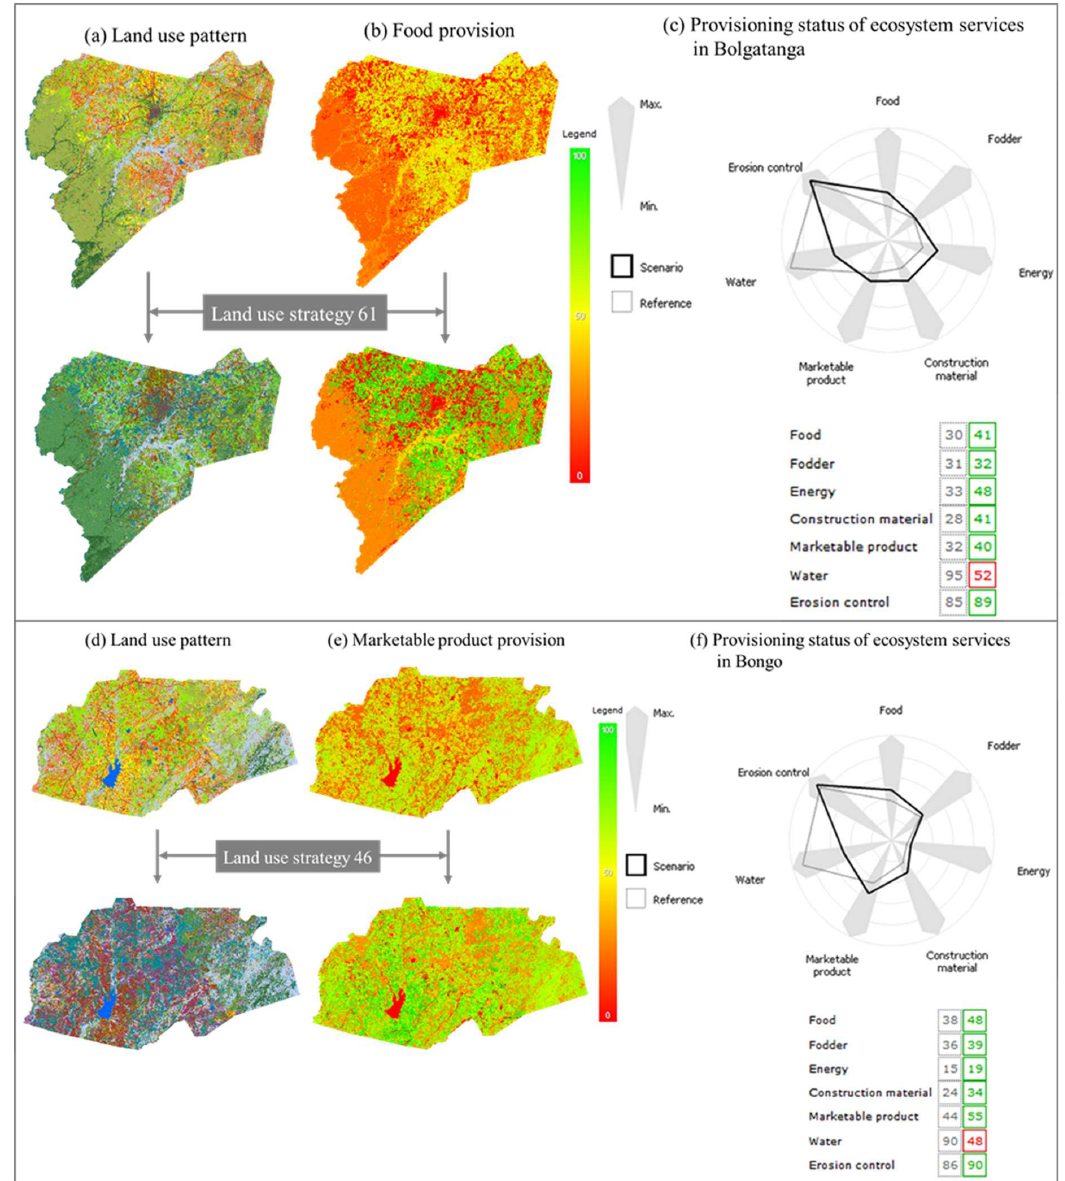
Figure 6. Future land-use pattern and changes in the provision of ecosystem services according to locally recommendable land-use strategies in Bolgatanga (top) and Bongo (bottom). The application of land-use strategies generates future land-use pattern ( a , d ). The spatial distribution of ecosystem services (e.g., food and marketable products provision) is influenced by the newly generated land-use pattern ( b , e ). The spider chart and the table present the changes in the provision of overall ecosystem services at district level compared to the current status as reference values ( c , f ). Green numbers indicate an increase in the provision of ecosystem services, and a red number signifies a decrease in the provision of ecosystem services. The images were captured from